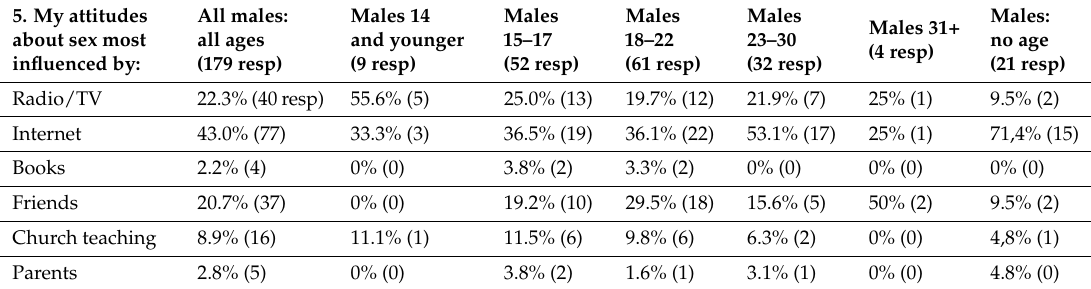
Table 5. Attitudes about Sex Most Influenced by? All Males.